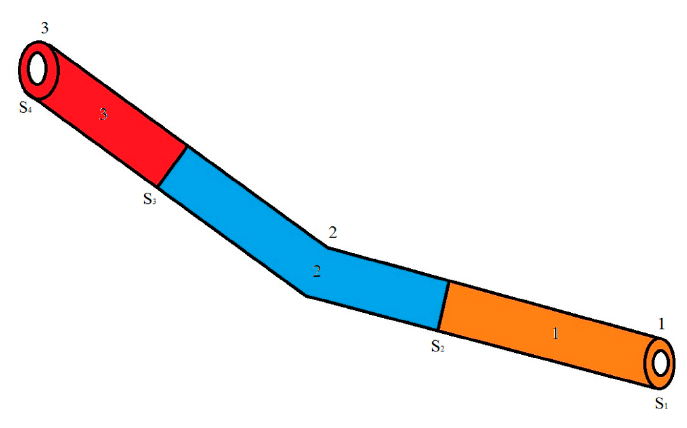
Figure 3. Schematic of a wellbore with two wellbore segments and three slurry segments. S refers to cross-section area and the numbers refer to the index of fluid segments.